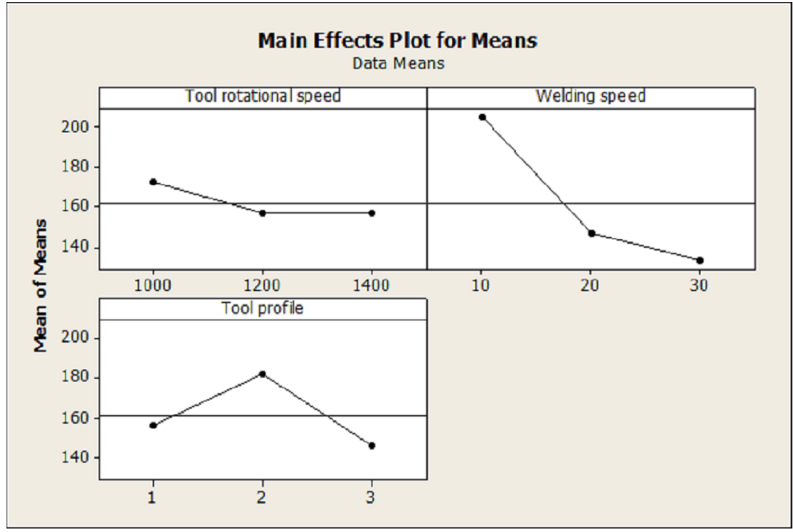
Figure 7. Main effects plot for the means for tensile strength.